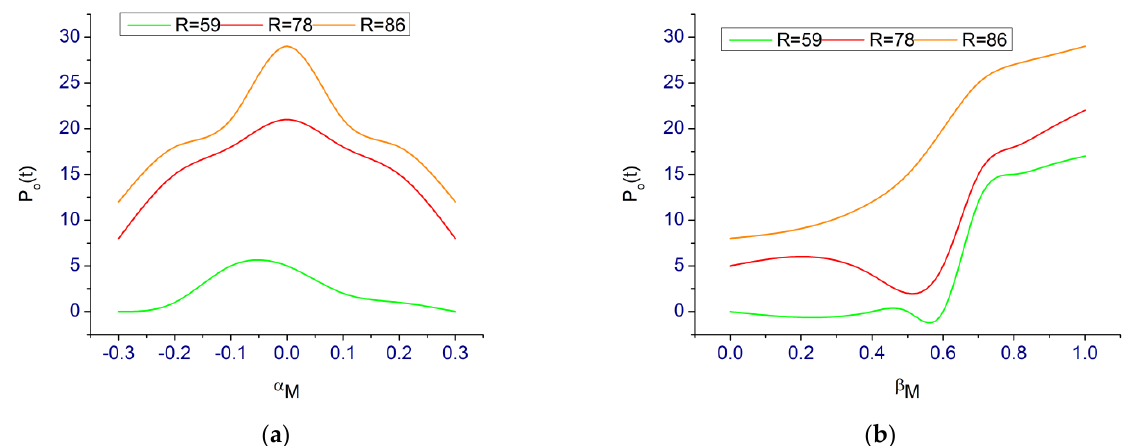
Figure 7. 𝑃 𝑜 (𝑡) Analyses. ( a ) 𝑃 𝑜 (𝑡) for the varying 𝛼 𝑀 . ( b ) 𝑃 𝑜 (𝑡) for the varying 𝛽 𝑀 Figure 7. P o ( t ) Analyses. ( a ) P o ( t ) for the varying α M . ( b ) P o ( t ) for the varying β M . The analysis is performed for 𝑃 𝑜 (𝑡) under the varying 𝛼 𝑀 (Range:−0.4 to +0.3) and Table 2. P o ( t ) and Obj F ( t ) Analyses. 𝐹 𝑀 (Range: −0.4 to 1) in Figure 7. This is determined using the classifications are performed using 𝐻𝑚𝑝 𝑖 . In the varying processes (level 1 and level 2), if 𝑇ℎ > 𝜃 𝑖𝑇ℎ 𝑟𝑎𝑡 then 𝐹(𝑋) is retained and therefore the 𝑃 𝑟𝑎𝑡 (7) is obtained. It satisfies the maximum conditions in the HAS due to which risks are thwarted (Figure 7). In the final analyses, the High 𝑃 𝑜 (𝑡) and 𝑂𝑏𝑗 𝑝 (𝑡) are analyzed for different risk factors, as presented in Table 2. Table 2. 𝑃 𝑜 (𝑡) and 𝑂𝑏𝑗 𝐹 (𝑡) Analyses.